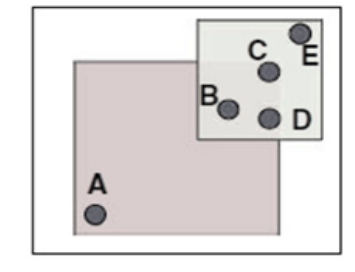
Figure 7. Homogeneity attack [42].